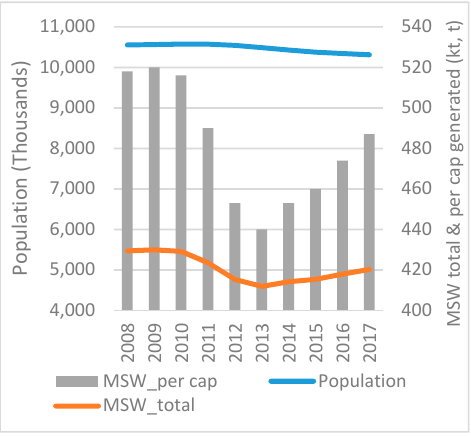
Figure 43. Population and MSW production in Portugal 2008–2017 (EUROSTAT 2019a, 2019c). Soc. Sci. 2019 , 8 , x FOR PEER REVIEW